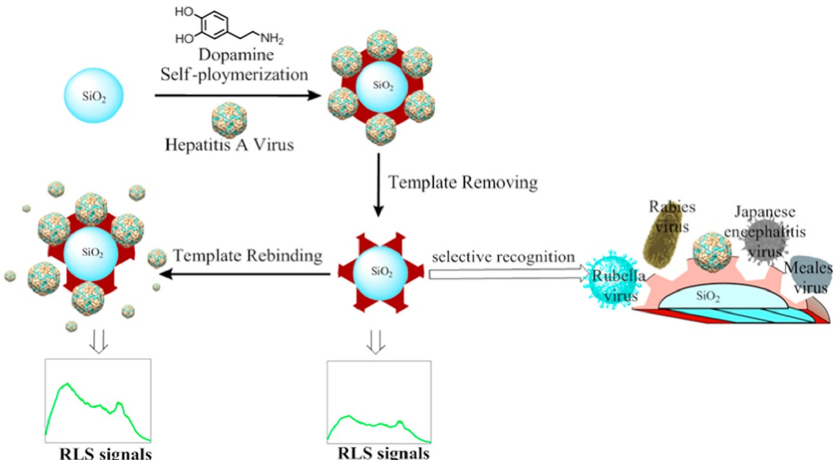
Figure 6. Schematic representation of the preparation of Hepatitis A-imprinted poly(dopamine). Reprinted from [201]. Copyright (2017), with permission from Elsevier.